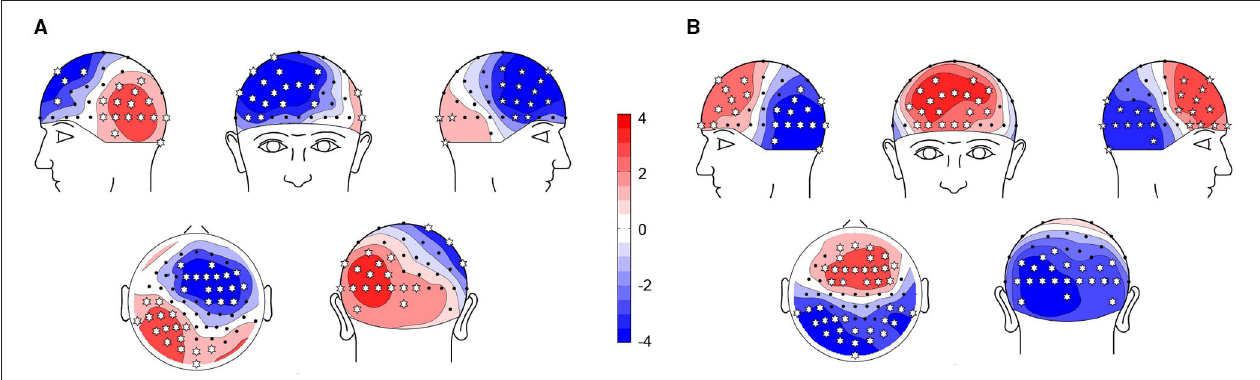
FIGURE 3 | Comparison of TEPs using cluster-based permutation tests. Red means TEP of cognitive impairment (CI) is higher than HC, blue means TEP of CI is lower than healthy controls (HC). The asterisk indicates that p < 0.01. (A) N100: CI vs. HC. (B) P200: CI vs. HC.